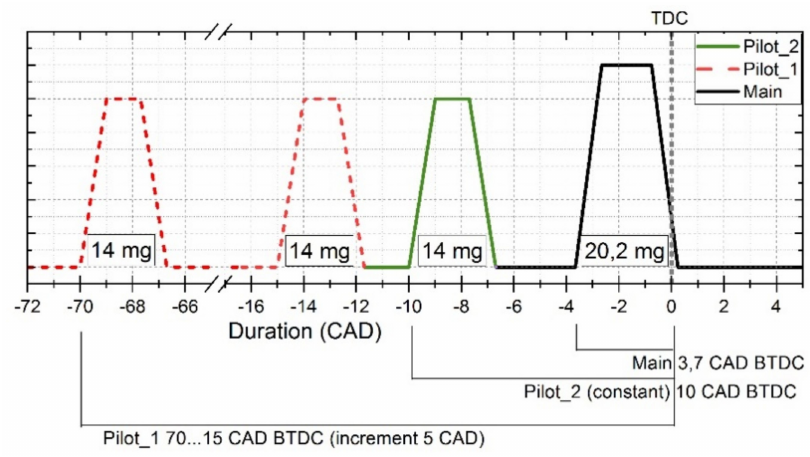
Figure 6. The injection strategy for the second pilot SOI 10 CAD BTDC. The reference value for each parameter (base case value) is marked by a dashed red line. Each of three lines on the graph in Figure 7 correspond to the SOI of the second pilot (the values are shown in legend and on Figures